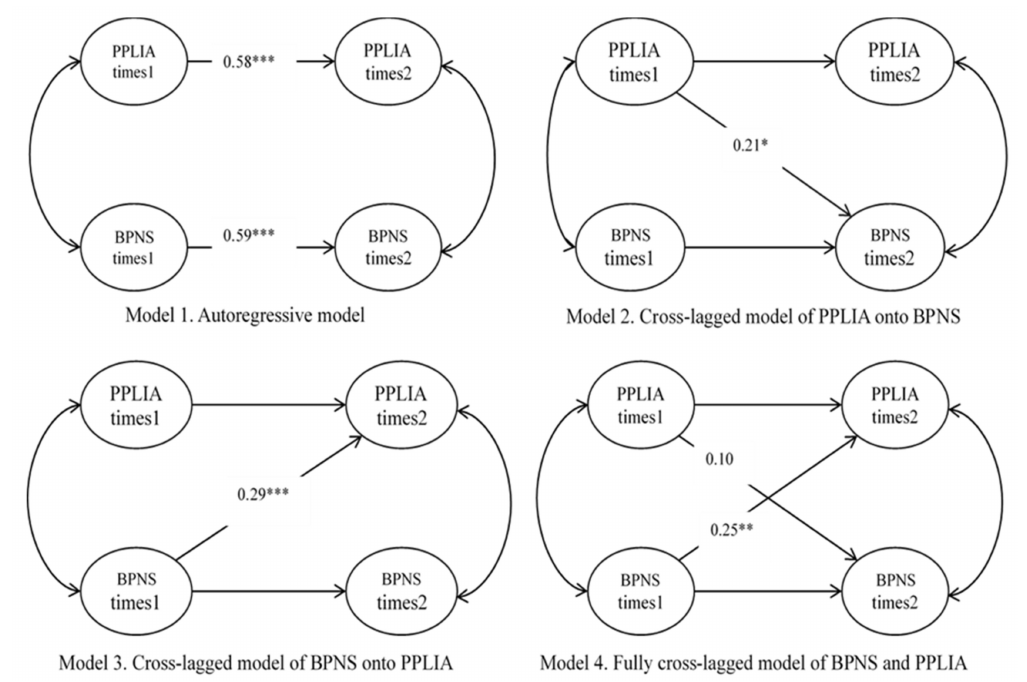
Figure 1. The conceptual path models. * p < 0.05; ** p < 0.01; *** p < 0.001.